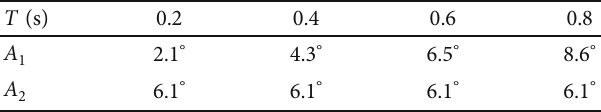
Table 2: Simulation results of walking at fi xed